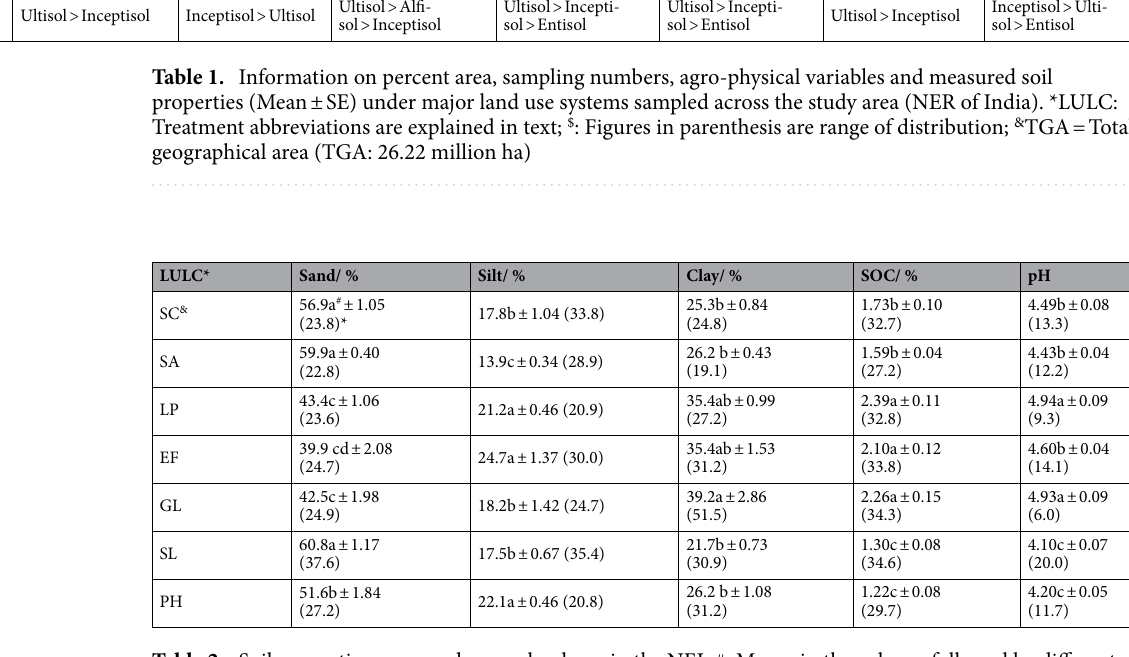
Table 2. Soil properties measured across landuses in the NEI. #: Means in the column followed by different letters (a-d) are statistically significant at p < 0.05. *Figures in parenthesis are coefficient of variations (CV) in %. SC & : Shifting cultivation, SA: Settled agriculture, LP: lowland paddy, EF: Evergreen forest, GL: Grassland, SL: Scrubland, PH: Plantation and